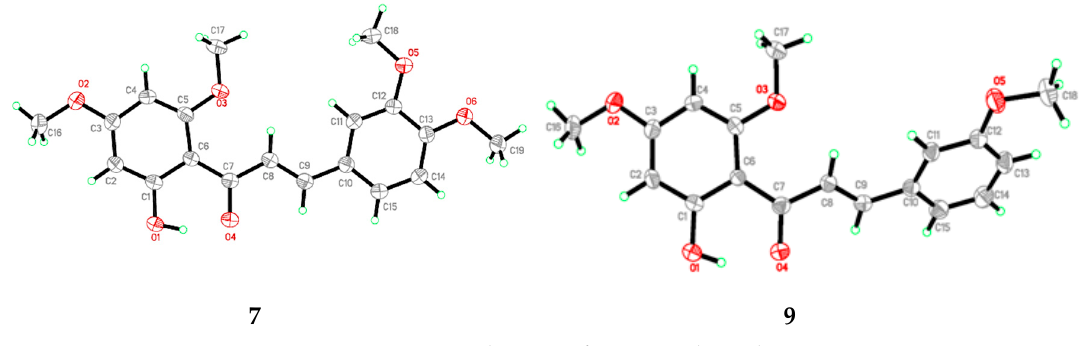
Figure 2. ORTEP diagram of compound 7 and 9 .